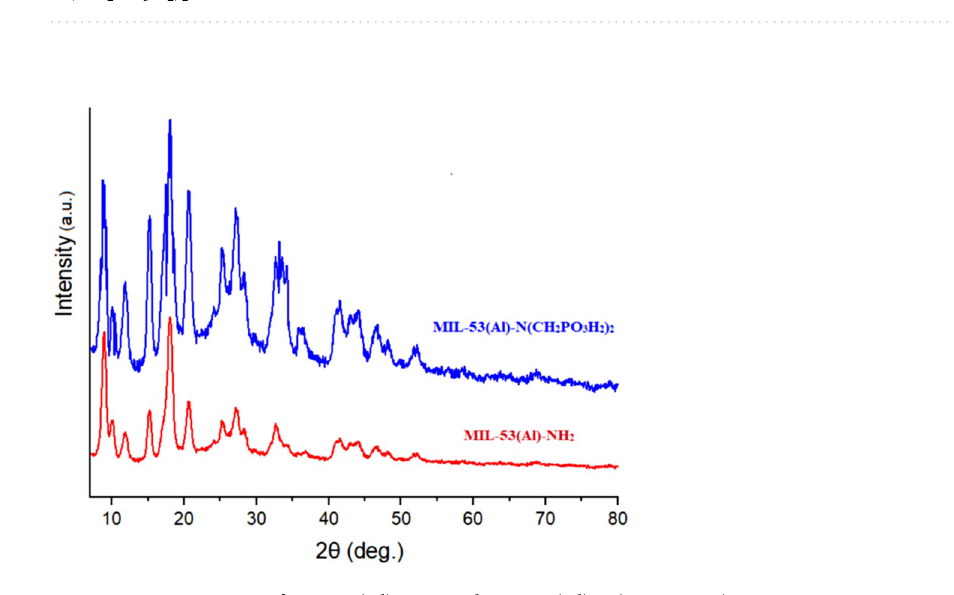
Figure 8. XRD pattern of MIL-53(Al)-NH 2 and MIL-53(Al)-N(CH 2 PO 3 H 2 ) 2